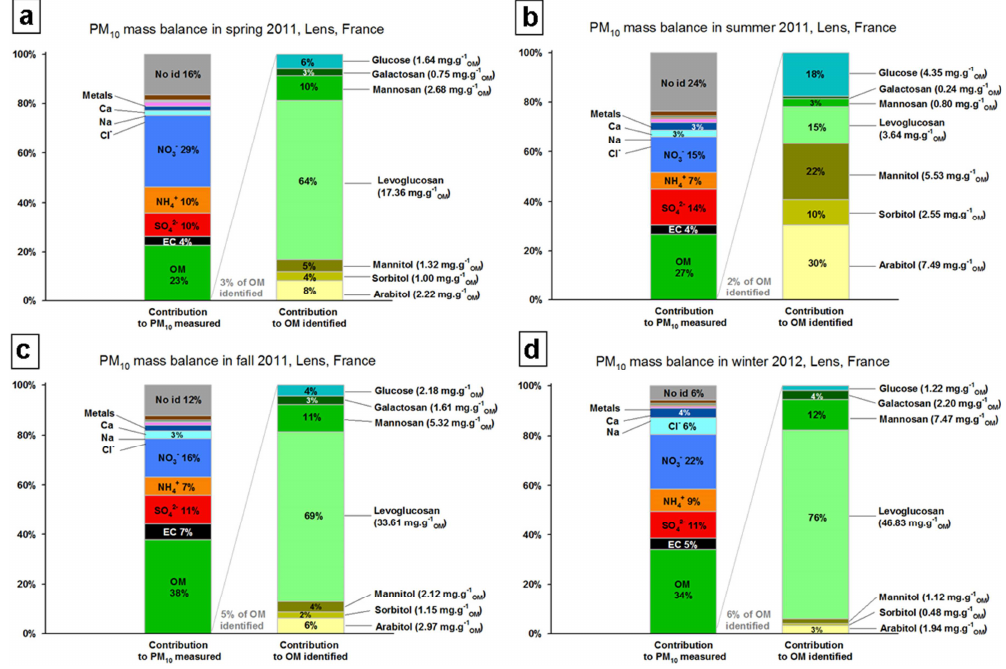
Figure 3. PM mass balance at Lens in spring (a), summer (b), fall (c) and winter (d) 2011-2012. 2 Fig. 3. PM 10 mass balance at Lens in spring (a) , summer (b) , fall (c) and winter (d) 10